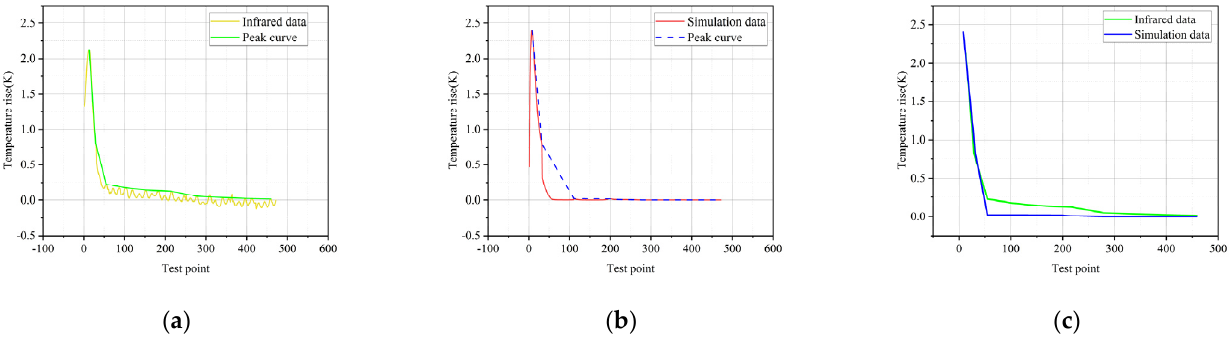
Figure 13. ( a ) Infrared temperature-rise curve of #2; ( b ) simulated temperature-rise curve of #2; ( c ) peak-curve comparison diagram of #2.